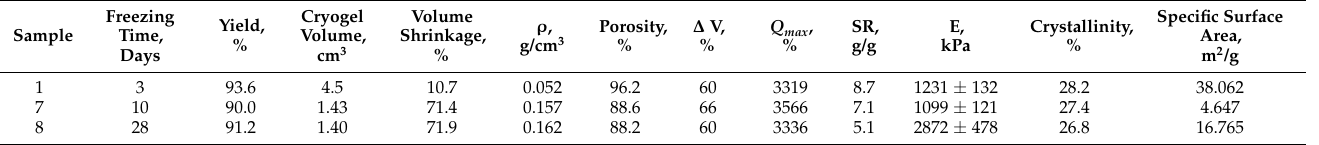
Table 4. Effects of freezing time on the properties of cryogels.